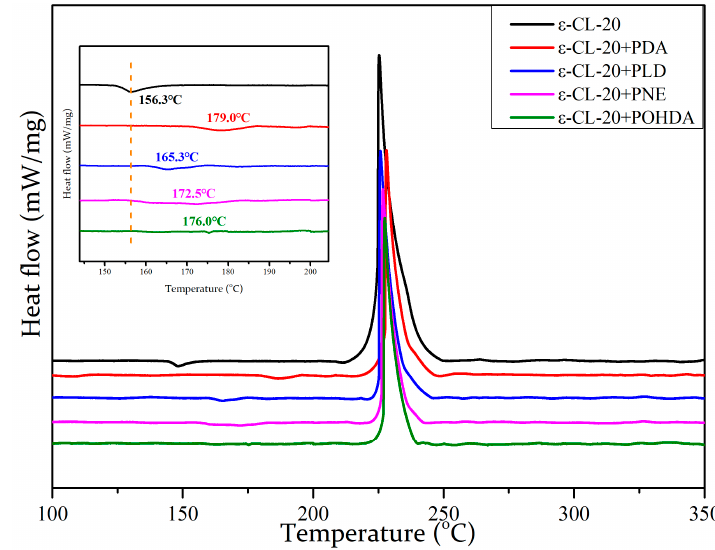
Figure 8. Differential scanning calorimetry (DSC) curves for epsilon ‐ CL ‐ 20 ( ε‐ CL ‐ 20) and different Di ff erential scanning calorimetry (DSC) curves for epsilon-CL-20 ( ε -CL-20) and composites. di ff erent Table 3. Thermal analysis data of epsilon ‐ CL ‐ 20 ( ε‐ CL ‐ 20) and different composites.